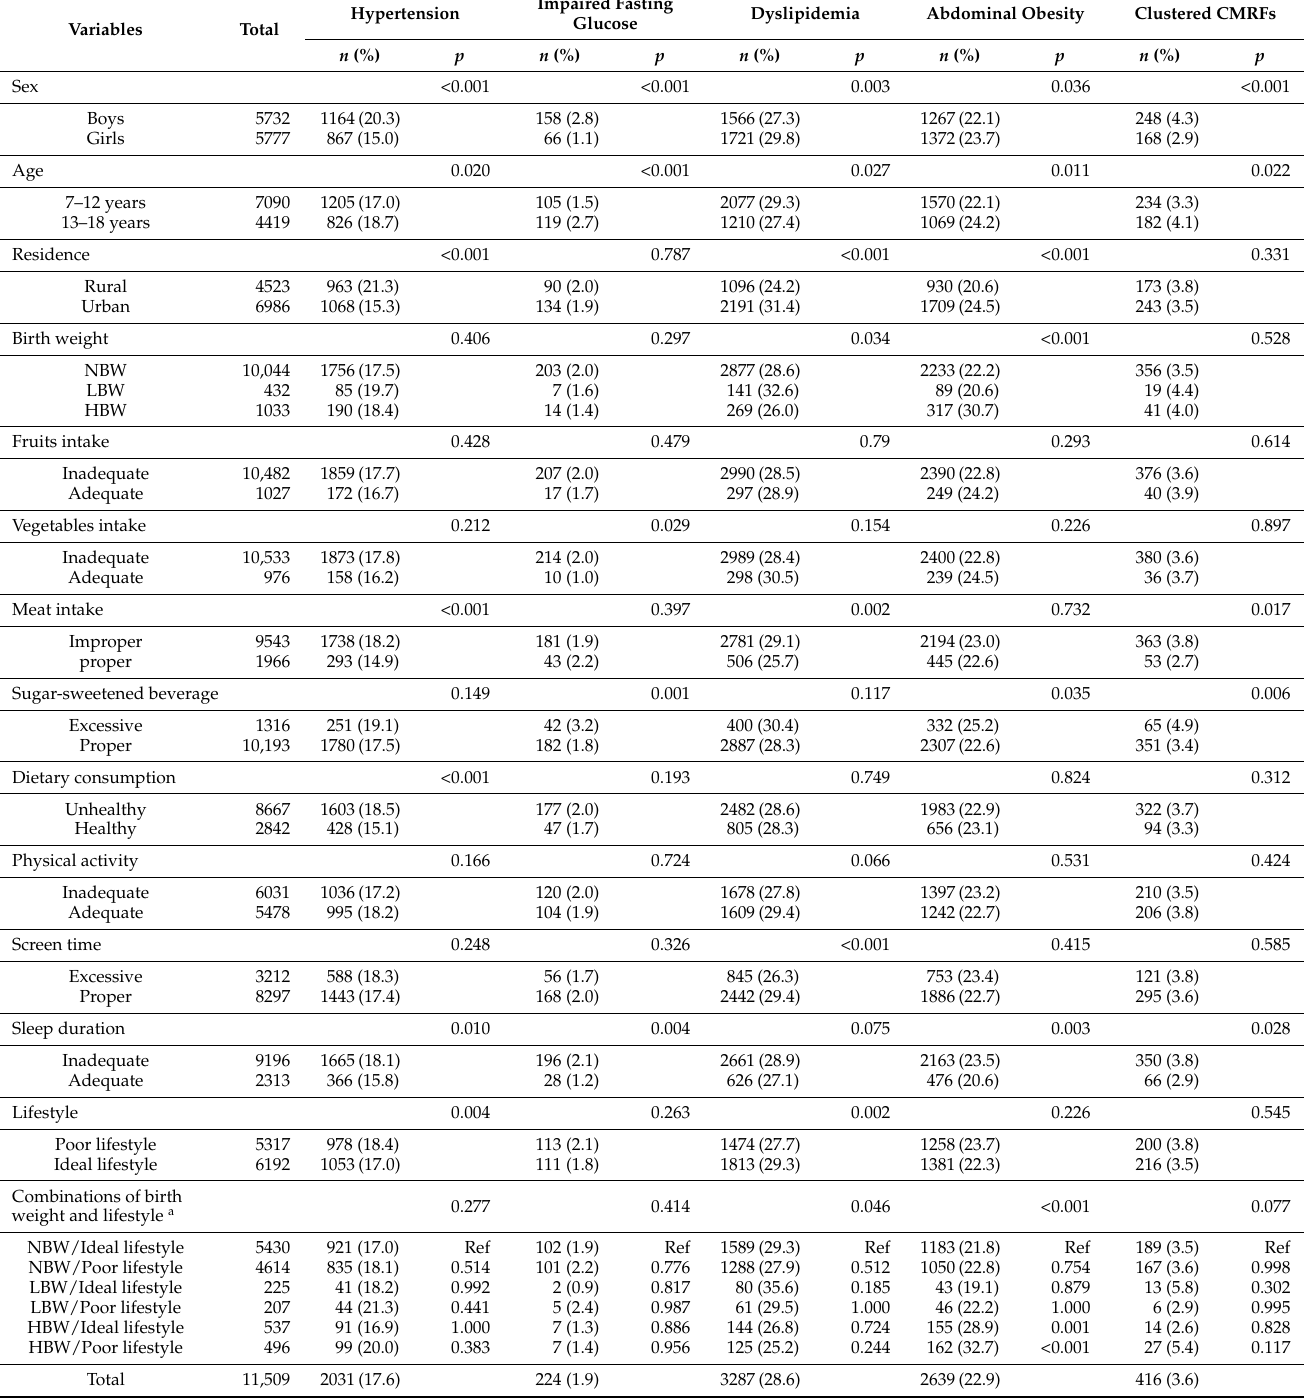
Table 2. Prevalence of CMRFs and clustered CMRFs in different